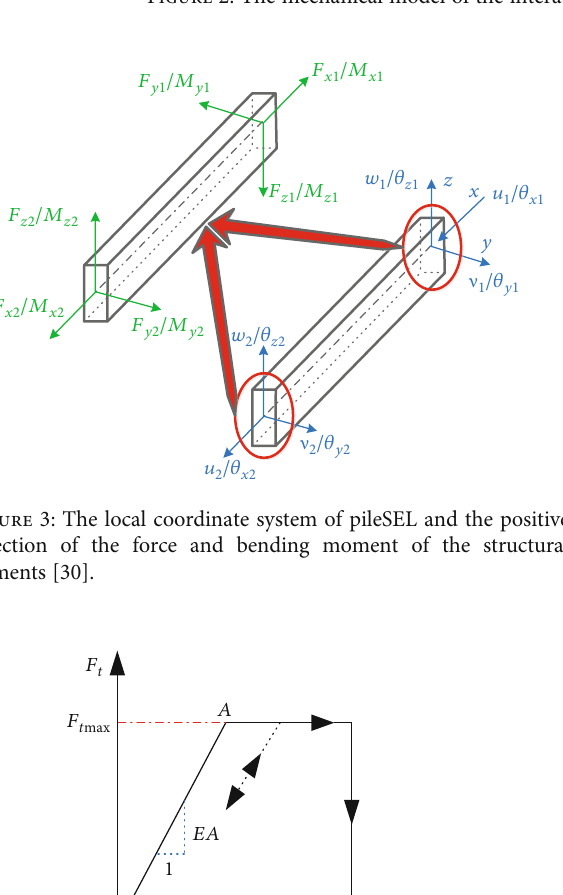
Figure 2: The mechanical model of the interaction between the pileSEL and the surrounding rock.